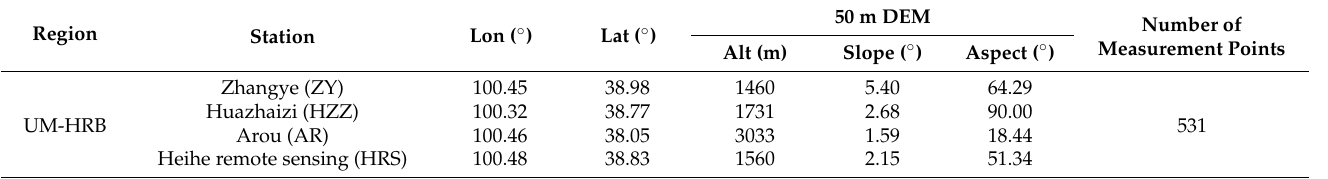
Table 2. Basic information about the pyranometer observation sites in two study